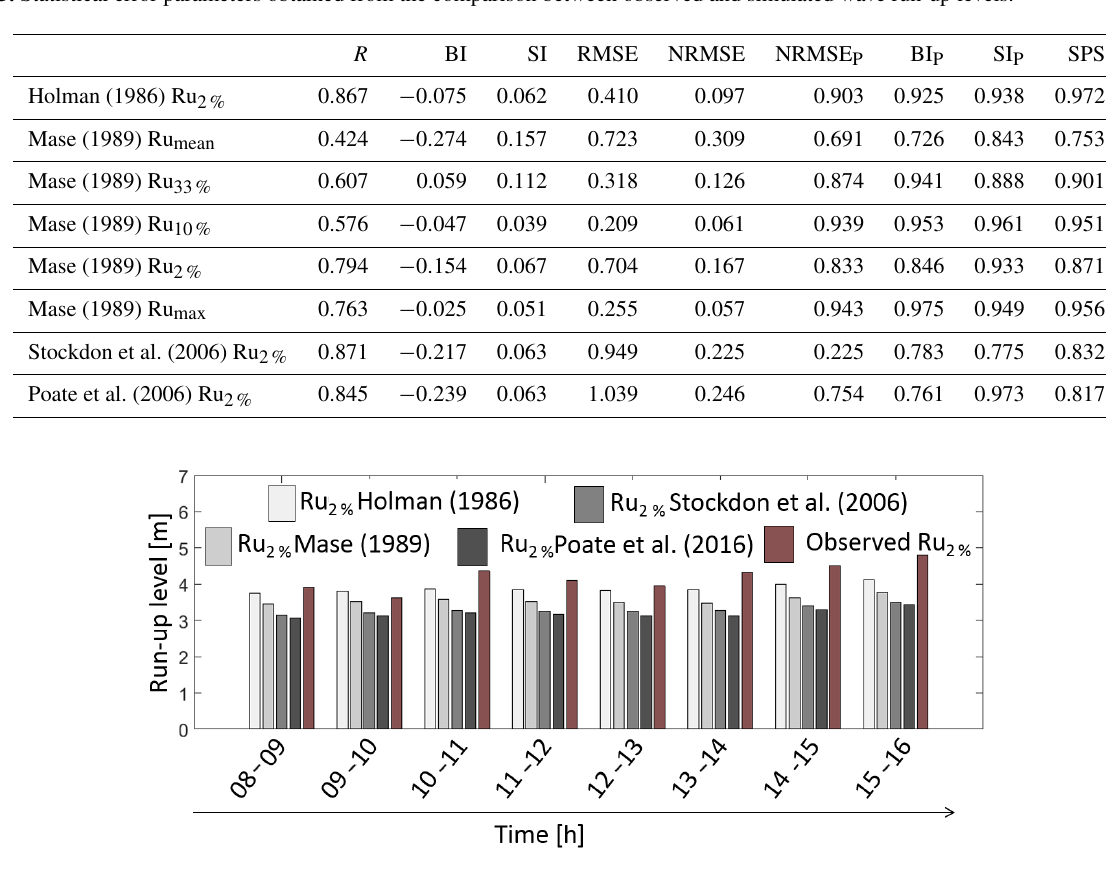
Table 3. Statistical error parameters obtained from the comparison between observed and simulated wave run-up levels.